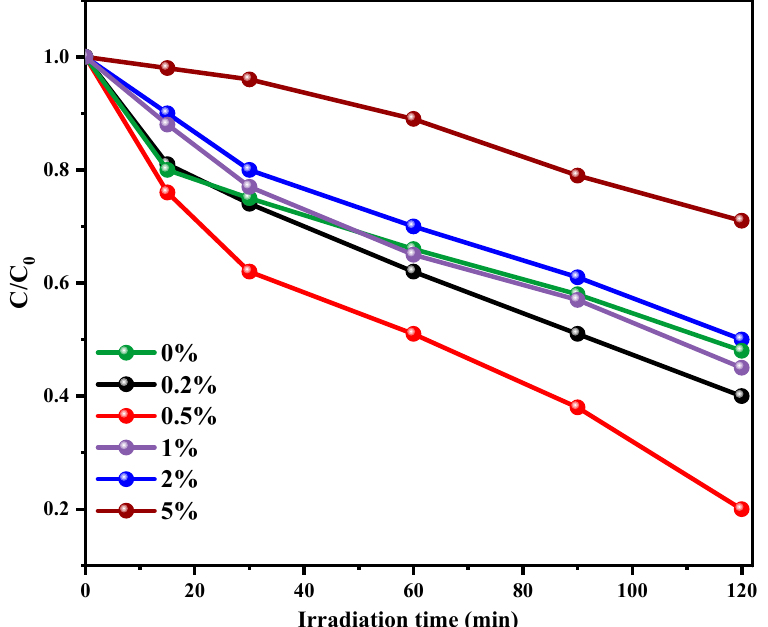
Figure 8. Conversion plots for the MB photodegradation for synthesized composite under solar light irradiation.